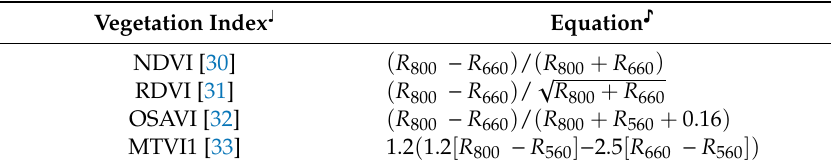
Table 1. Vegetation indices used for rice growth phenological stage monitoring and leaf area index